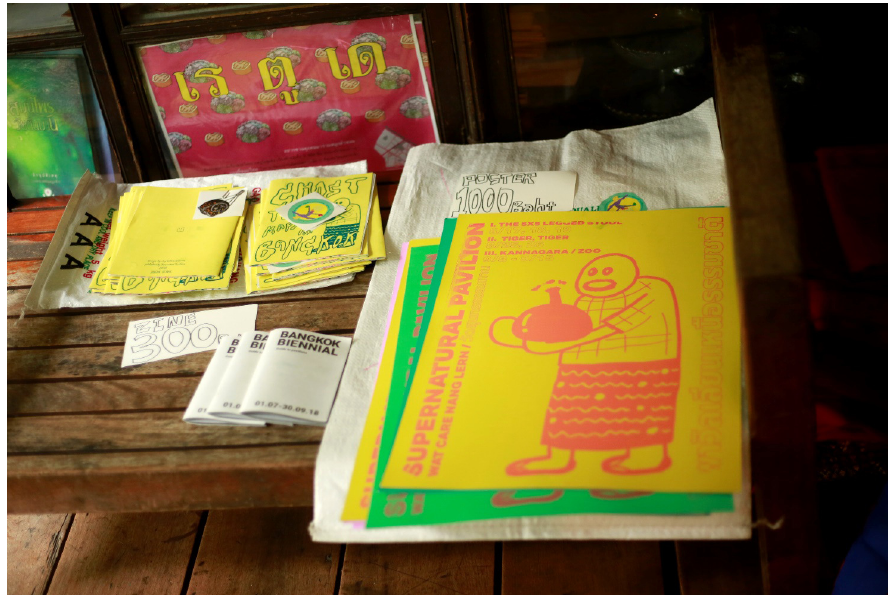
Figure 5. Zine and poster of Supernatural Pavilion at Baan Silapa (September 2018). Photo by TRMN, courtesy of Chiharu